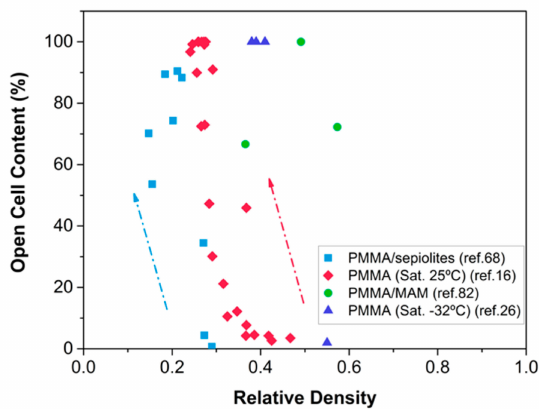
Figure 9. Open cell content as a function of the relative density for the different nanocellular polymers produced in our laboratory. Arrows indicate the increase of the foaming